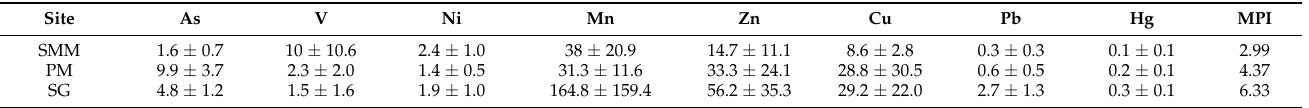
Table 2. Metal(loid) average annual concentrations (Mean ± SD) ( µ g g − 1 dw) in U. laetevirens collected at VL: SMM—Santa Maria del Mare; PM—Porto Marghera; SG—San Giuliano; MPI—metal pollution index.